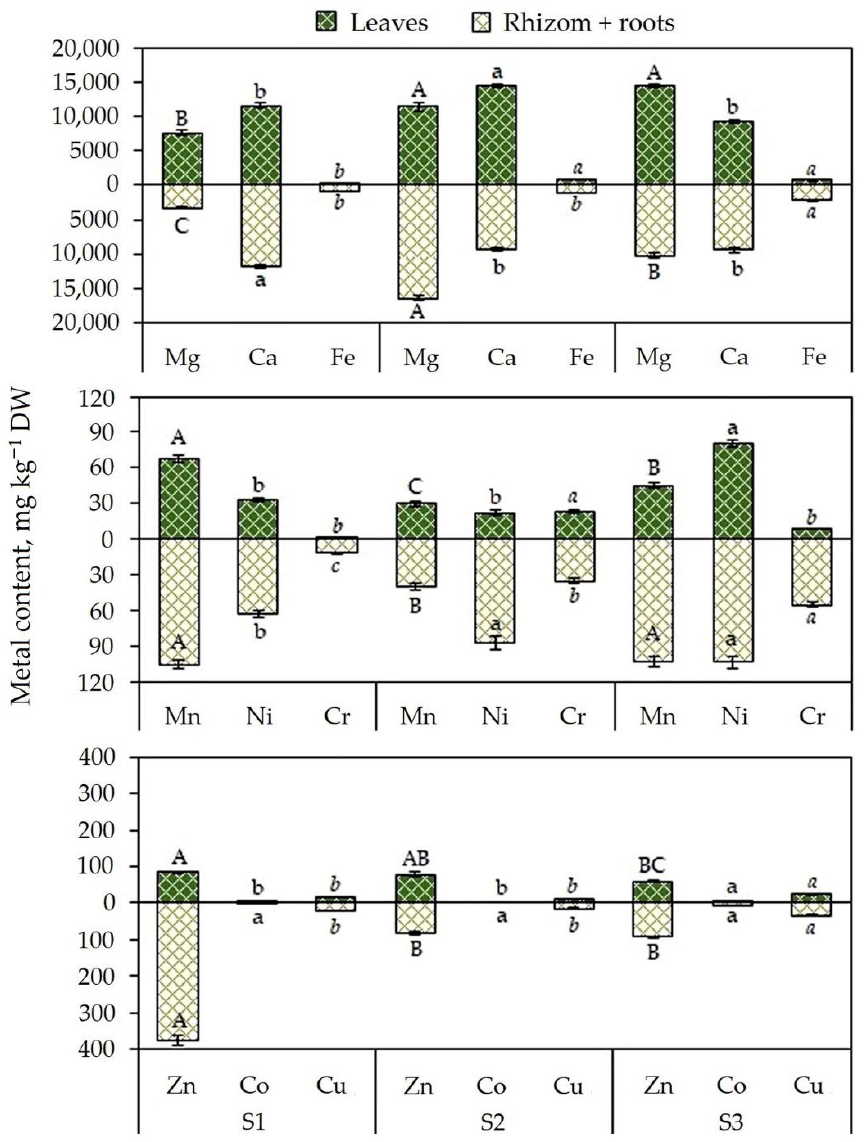
Figure 4. Metal content in the aboveground and underground organs of E. atrorubens growing on serpentine substrates. Data is presented as Means ± SE ( n = 4). Different alphabetical letters indicate a significant difference between the studied sites at p < 0.05. kg − 1 DW